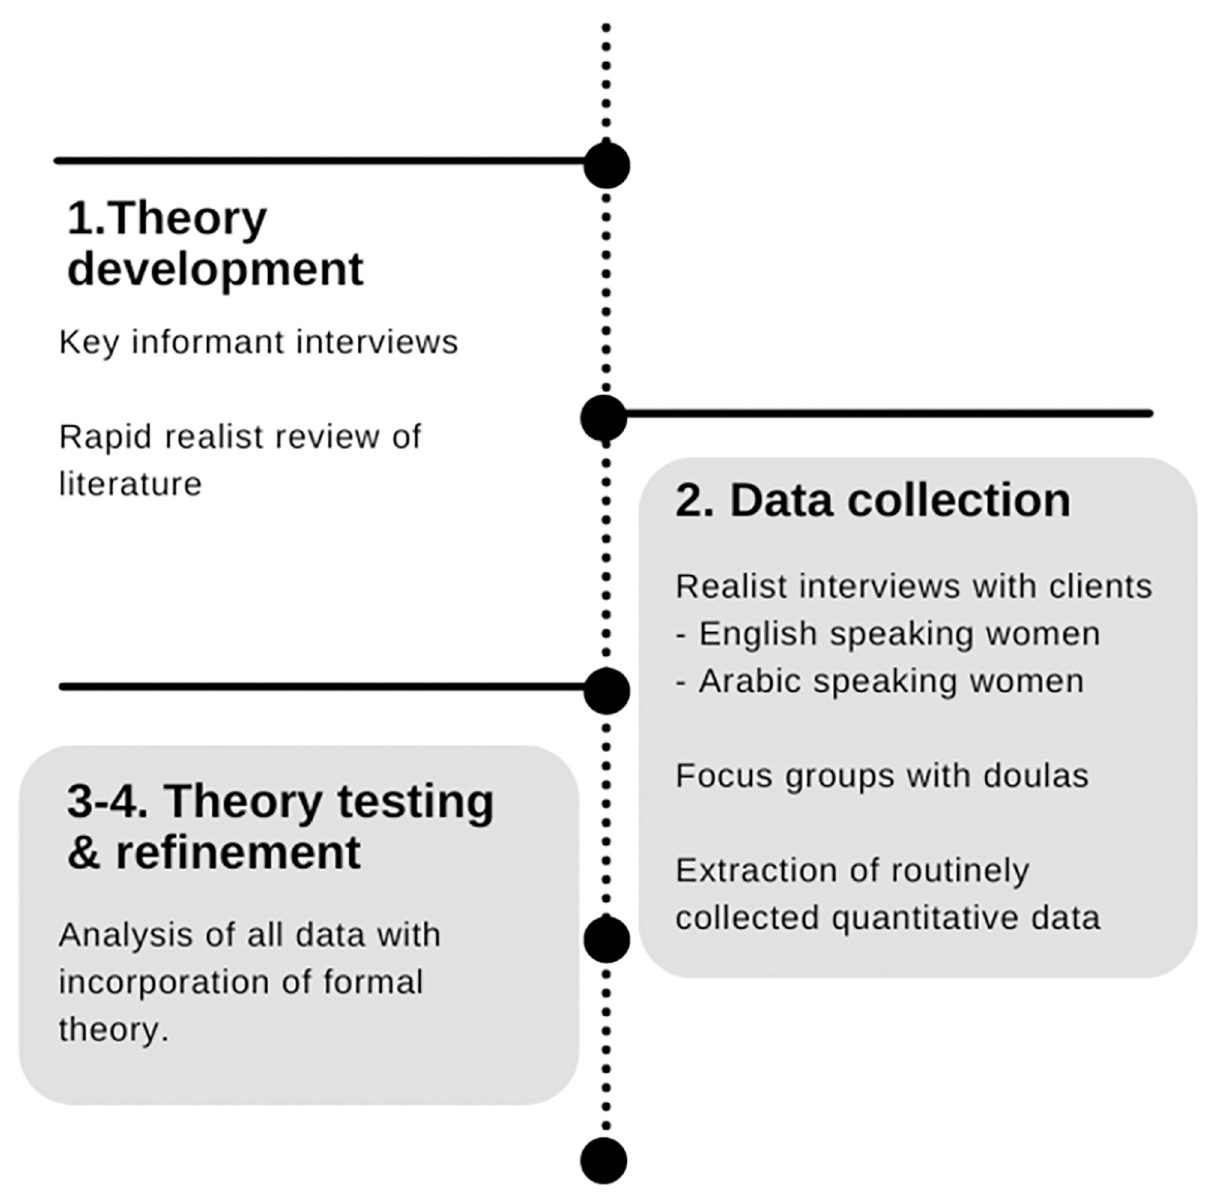
Fig 1. Evaluation design, with scope of this paper